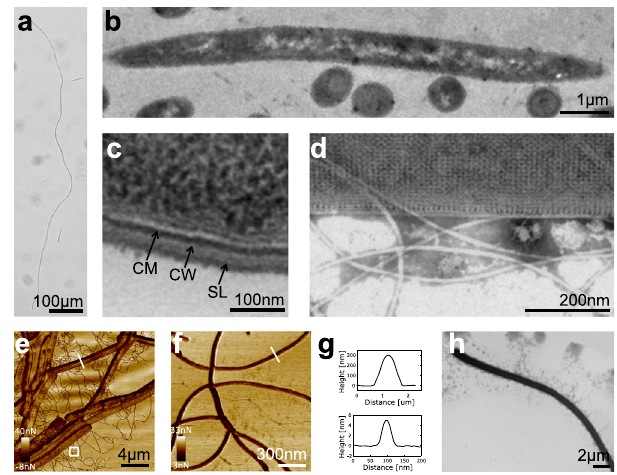
Fig. 1 Structures of L. varians GY32 cell, cell wall, and nanowire-like appendages. a The longest GY32 cell. b , c Longitudinal and cross-sections of GY32 observed with TEM. CM cytoplasm membrane, CW cell wall, SL S-layer. d Structure of the surface layer and appendages observed with TEM. e , f AFM adhesion maps of GY32 cells and appendages. F is a zoom- in of the white square in ( e ). g AFM height pro fi les of the cell (top) and appendage (below). h Representative cell of strain GY32 observed with